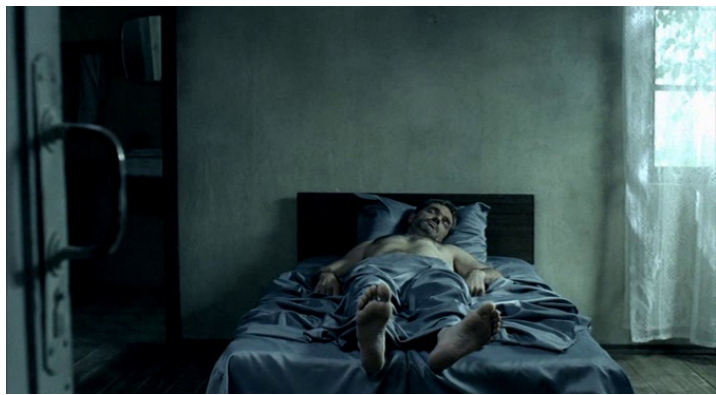
Figure 2. The Return (2003).